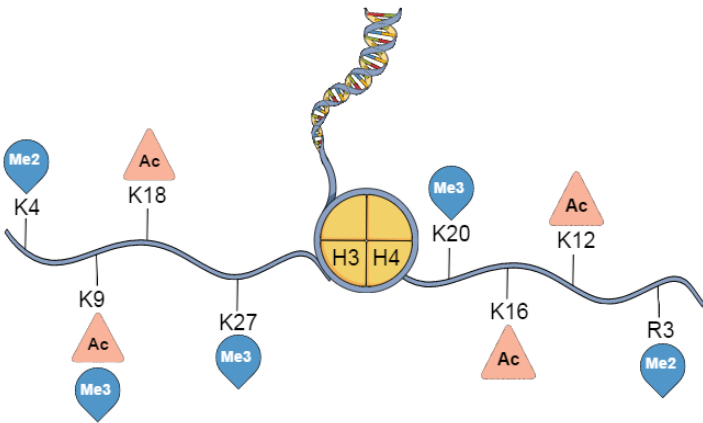
Figure 3. Posttranslational modifications to Histone 3 and 4 found in breast cancer. Key breast cancer associated modifications, to indicated residues, on Histone 3 (H3) or Histone 4 (H4). K: Lysine, R: Arginine, Ac: Acetylation, Me: Methylation, Di-Methylation (Me2), Tri-Methylation (Me3).